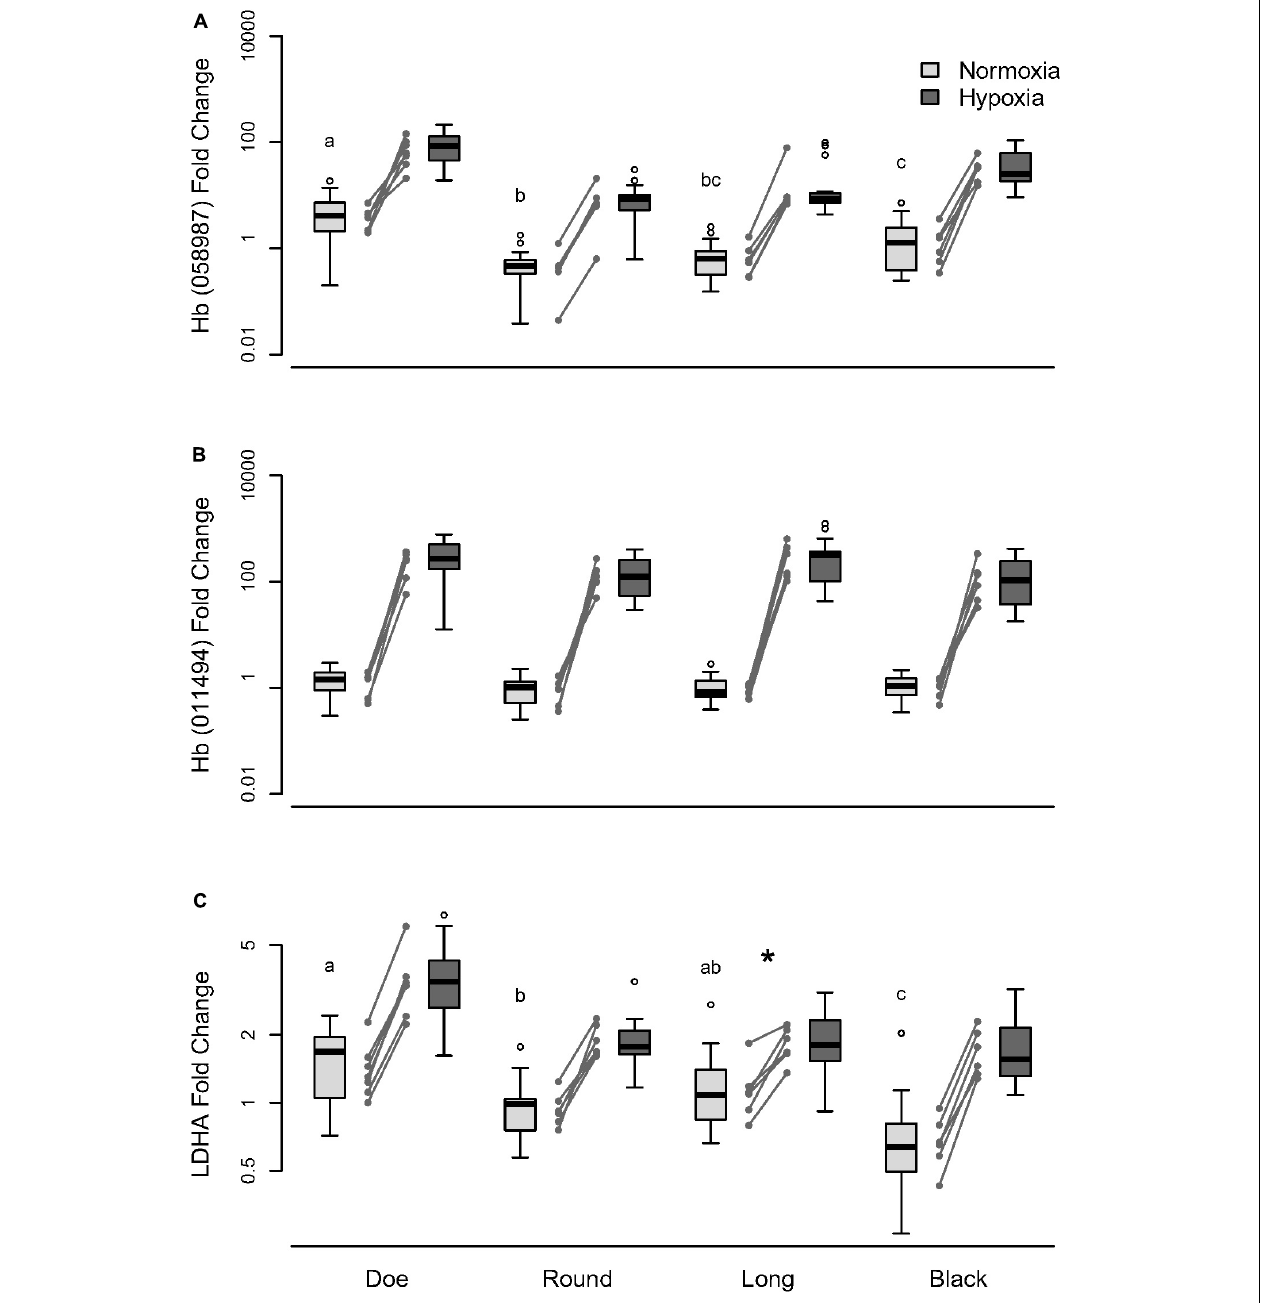
FIGURE 7 | Change in (A) Hb Daplx7pEVm058987, (B) Hb Daplx7pEVm011494, and (C) LDHA mRNA transcripts under hypoxic stress manipulation in D. pulicaria from four hypoxic lakes. D. pulicaria were isolated from each lake and reared in the lab under standard conditions for at least two generations prior to treatment. The treatment oxygen environment was either normoxia (ambient; 21% O2) or hypoxia (3% O2). Baseline expression labeled with different letters indicate significant differences ( p < 0.05). The asterisk (*) indicates significantly lower LDHA sensitivity to hypoxia in Long lake compared to Doe and Black lakes.